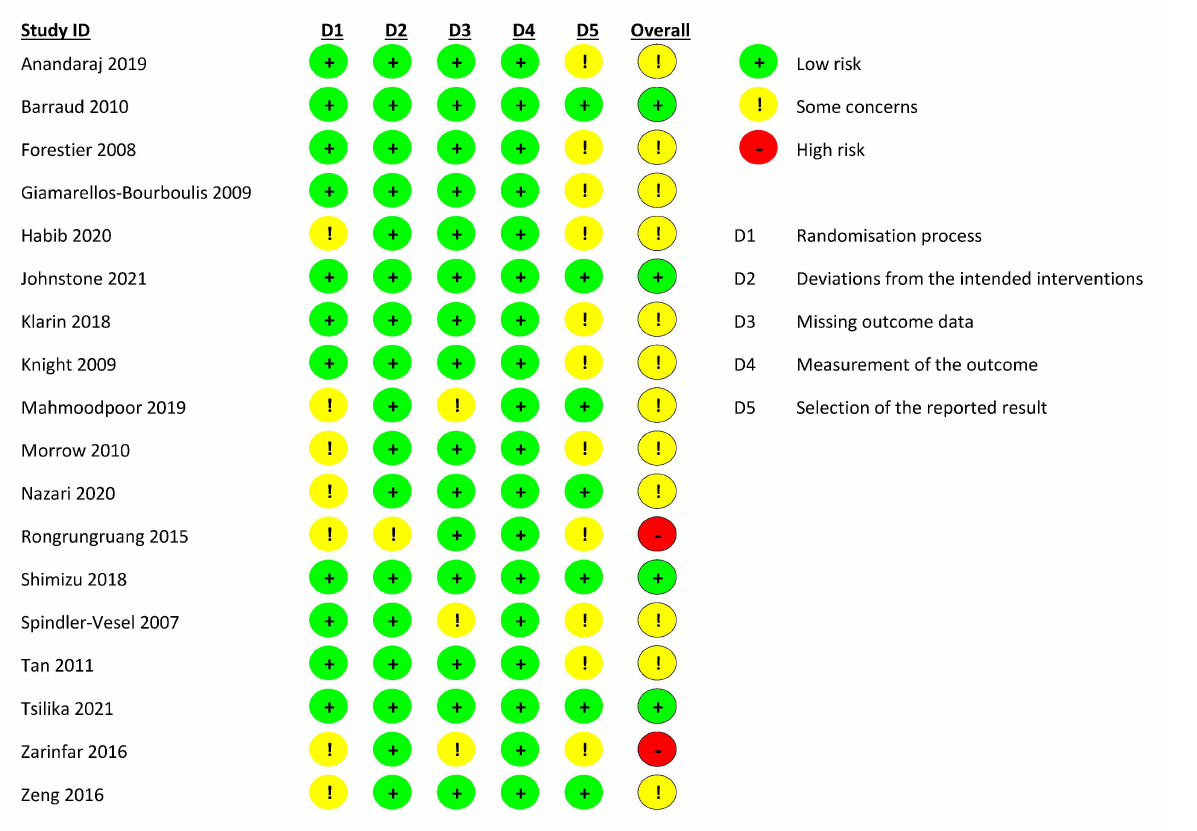
Figure 2. Risk of bias assessment for each included